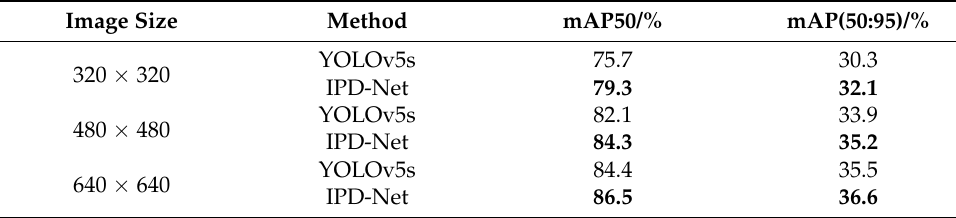
Table 2. Experimental results with different input image sizes.